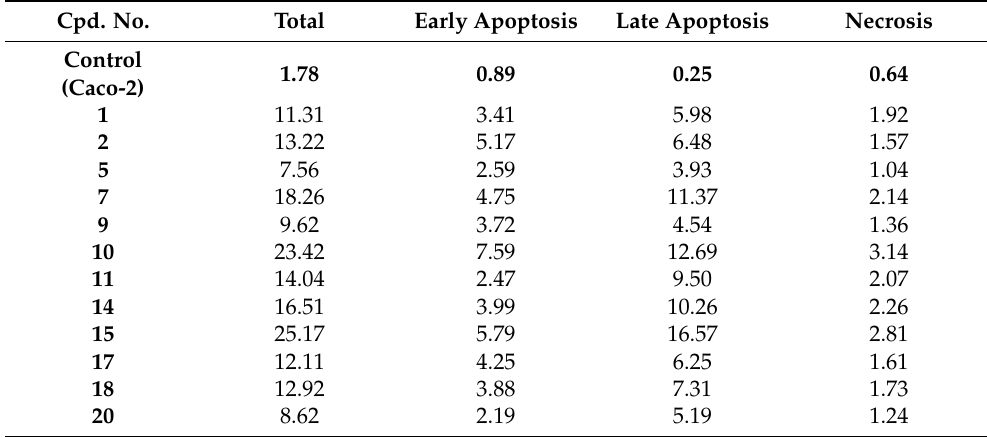
Table 5. Detection of different types of apoptotic cells induced in Caco-2 cells following treatment with parent compounds and their derivatives using annexin-V FITC/PI staining. Cpd. No. Total Early Apoptosis Late Apoptosis